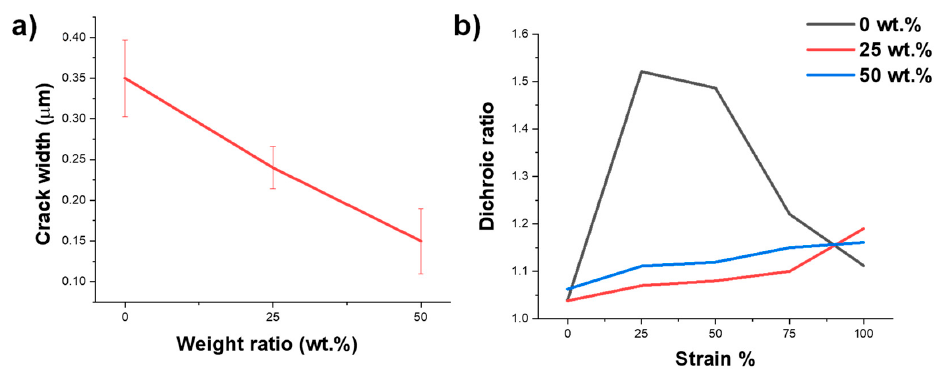
Figure 3. ( a ) The crack width values extracted from optical and atomic force microscope images of blend films at 100% strain before thermal annealing; ( b ) dichroic ratios of P(DPPTVT): LPE blends determined by polarized UV-vis spectroscopy.